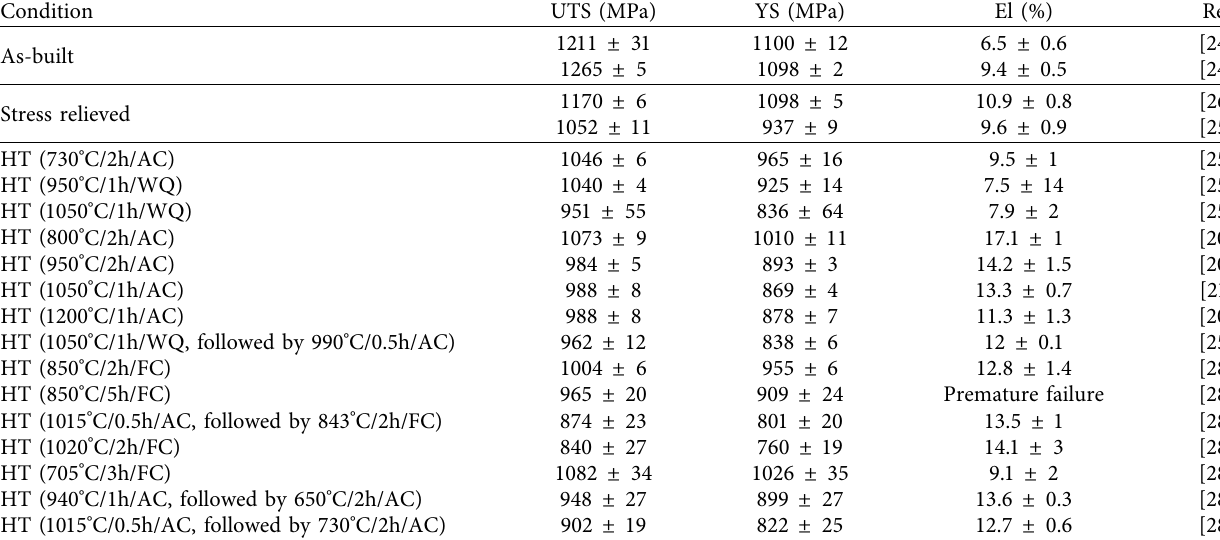
Table 1: Tensile properties of Ti6Al4V (ELI) parts built by DMLS and exposed to diferent heat treatment cycles [20, 24–28]. Condition